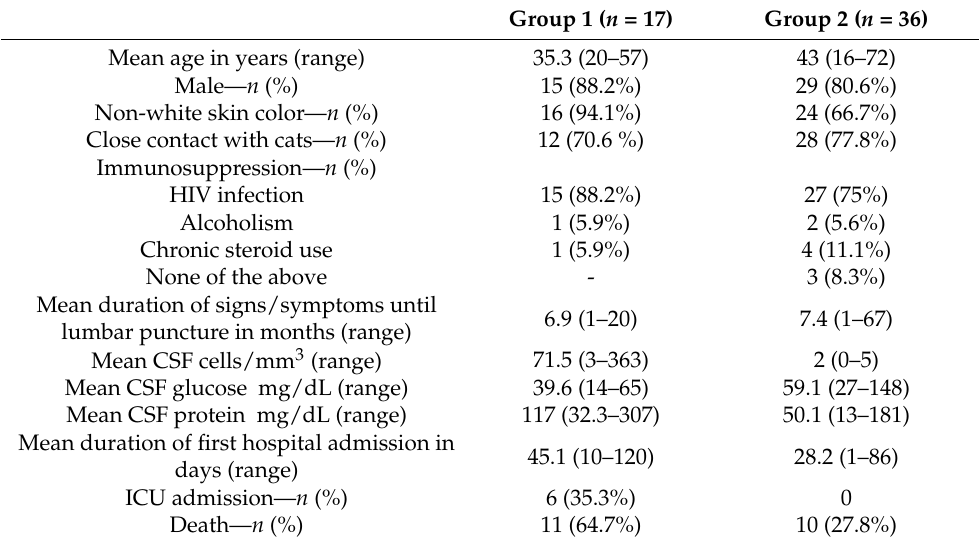
Table 1. Epidemiological, clinical, and laboratory findings of 53 patients with disseminated sporotri- chosis at INI/FIOCRUZ.